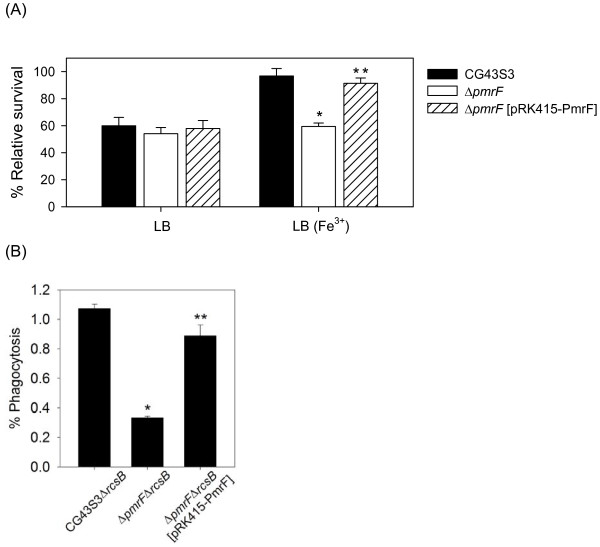
Involvement of K. pneumoniae pmrF gene in polymyxin B resistance and intramacrophage survival. (A) The log-phased cultures of K. pneumoniae CG43S3, the ΔpmrF mutant or ΔpmrF carrying pRK415-PmrF were grown in LB or LB supplemented with 1 mM Fe3+ and then challenged with 2 units/ml of polymyxin B. The survival rates are shown as the average ± standard deviations from triplicate samples. (B) The survival rates of K. pneumoniae CG43S3ΔrcsB, the isogenic ΔpmrFΔrcsB mutant, and ΔpmrFΔrcsB mutant strain carrying the complementation plasmid pRK415-PmrF within the mouse macrophage RAW264.7 were determined. The results shown are relative survival rates which were calculated from the viable colony counts of intracellular bacteria divided by individual original inoculums. Values are shown as the average of five replicas. Error bars, standard deviations. *, P < 0.01 compared to each parental strain; **, P < 0.01 compared to each mutant strain carrying pRK415-PmrF.